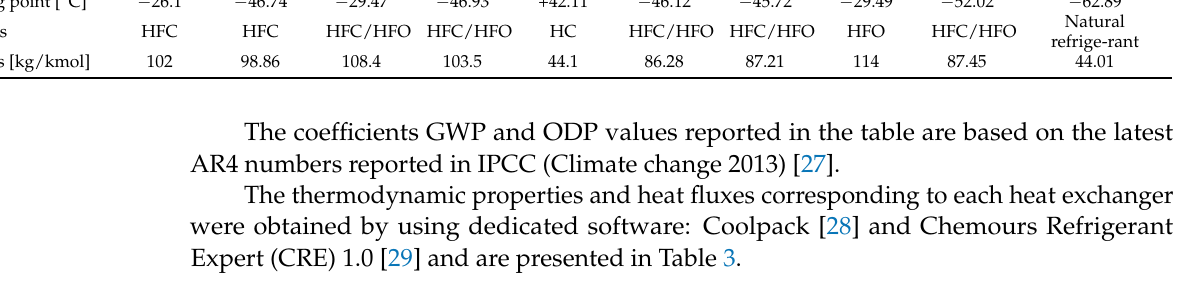
Table 3. Comparative analysis for 10